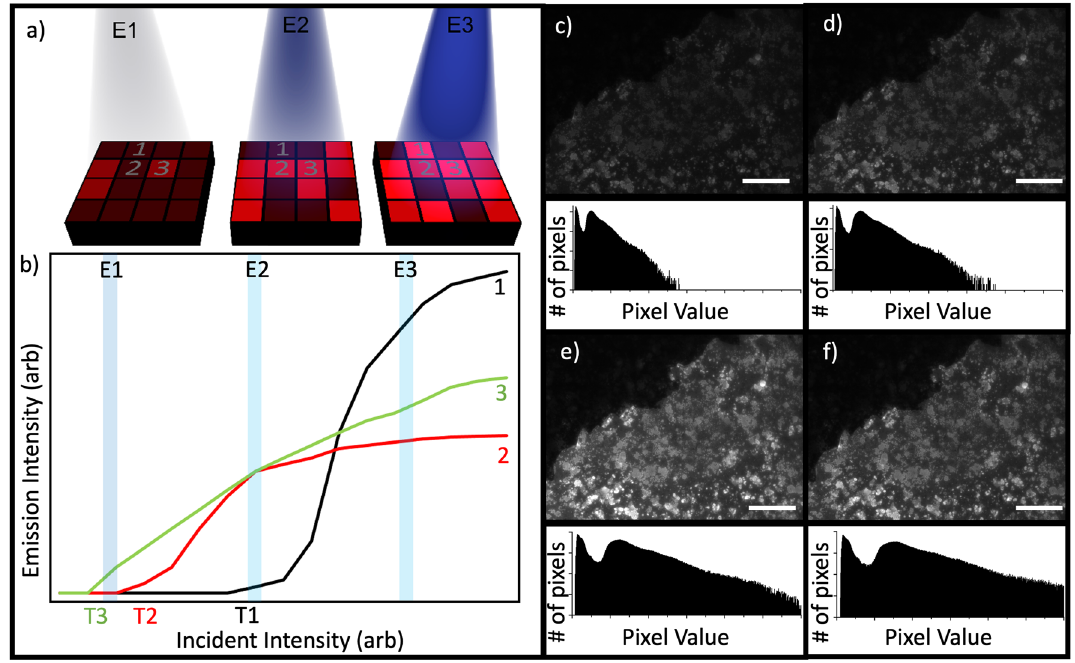
Figure 1. The concept of using the non-linear response of a quantum dot-based tag for authentication. ( a ) Illustrates a security tag’s surface, coated in quantum dots and divided into pixels for clarity. As the incident illumination increases (from left to right at 3 excitation powers, E1, E2, E3) the average amount of photoluminescence (shown in red) increases, but at different rates from region to region. T1, T2 and T3 show the switch-on intensities of different QD regions. ( b ) Sketches how the photoluminescence intensity from three example locations could vary differently with increasing excitation. ( c )–( f ) The top section of each panel shows photoluminescence from a thin film containing colloidal quantum dots at increasing excitation power, with pixel histograms underneath displaying the number of pixels recording each intensity value (0 to 65,355) at the different incident powers: 36.4 μW ( c ), 57.6 μW ( d ), 91.4 μW ( e ), and 145 μW ( f ). Scale bar represents 50